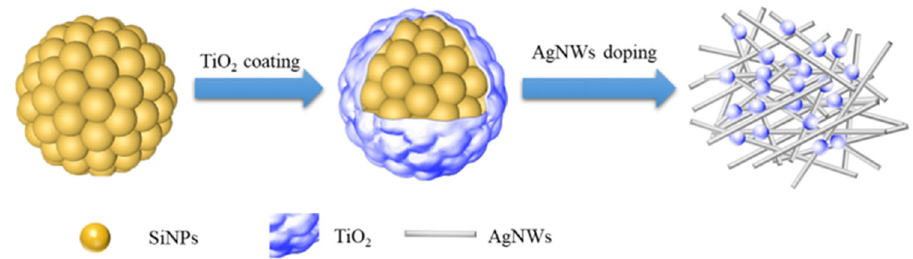
Figure 1. Schematic structure of SiNPs@TiO 2 /AgNWs.